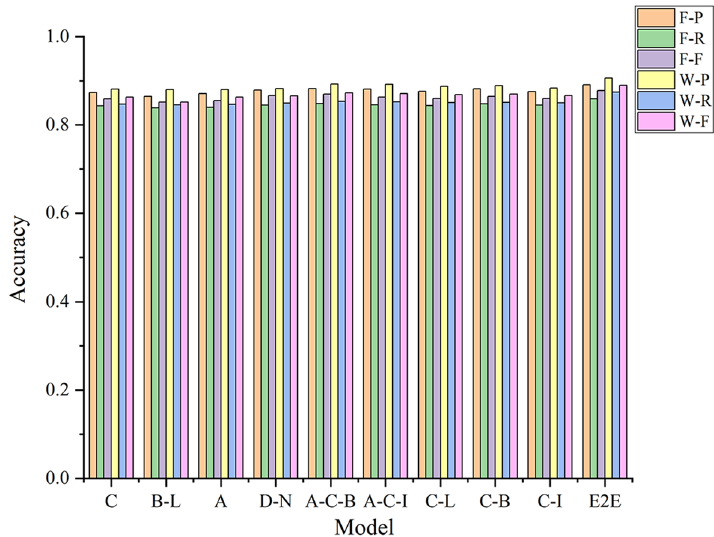
Figure 11. Effect of different deep learning on the evaluation criteria values for Quick Bird images.